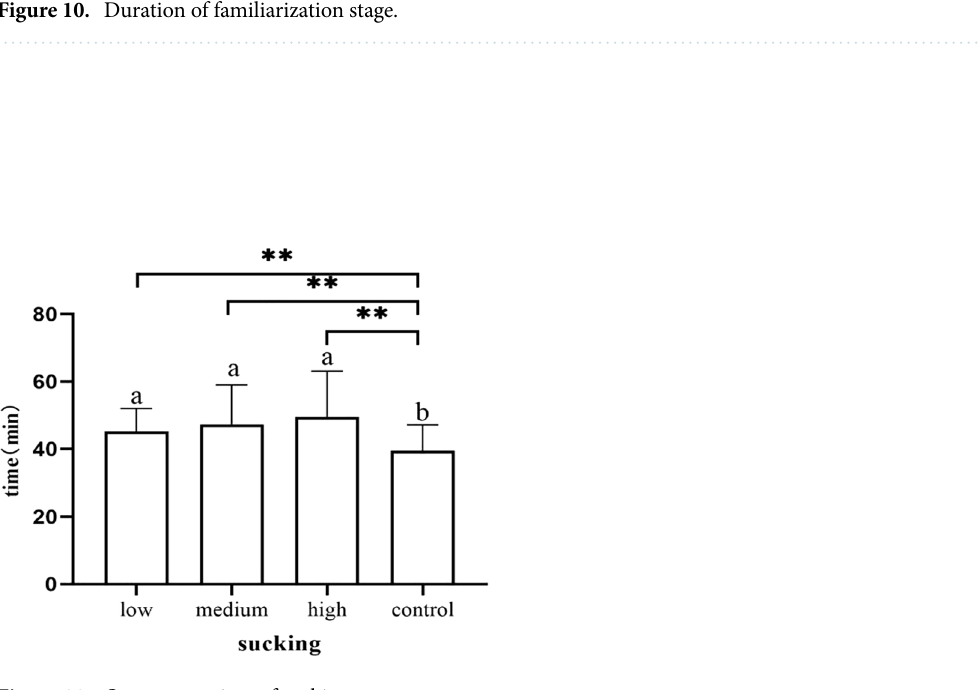
Figure 11. Occurrence time of